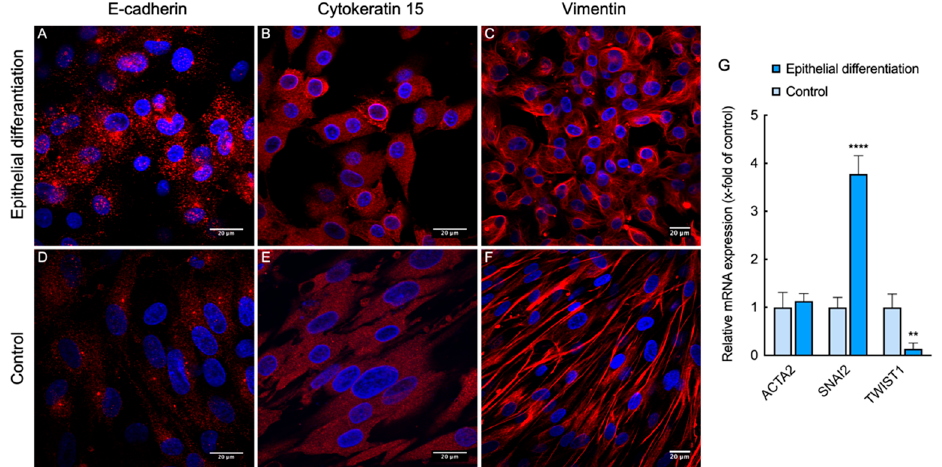
Figure 6. Confocal images of immunocytochemistry assay of L-MSCs-EGFP after 14 days of epithelial differentiation. Cells were stained with primary antibodies against marker associated with cell junctions—E-cadherin ( A , D ), and intermediate filaments—cytokeratin 15 ( B , E ) and vimentin ( C , F ). ( A – C ) demonstrate L-MSCs-EGFP after induction in epithelial differentiation medium. ( D – F ) demonstrate control L-MSCs-EGFP. Scale bars—20 micrometers ( µ m). ( G ). Comparative gene expression analysis of ACTA2, SNAI2, and TWIST1 in L-MSCs-EGFP after 14 days of epithelial differentiation. The plot shows the expression of mRNA in studied cells relative to the housekeeping gene HPRT1. Data represented as average ± S.D. from three independent experiments ( n = 3; ** and **** corresponds to p < 0.001 and 0.0001 after two-way ANOVA, respectively).